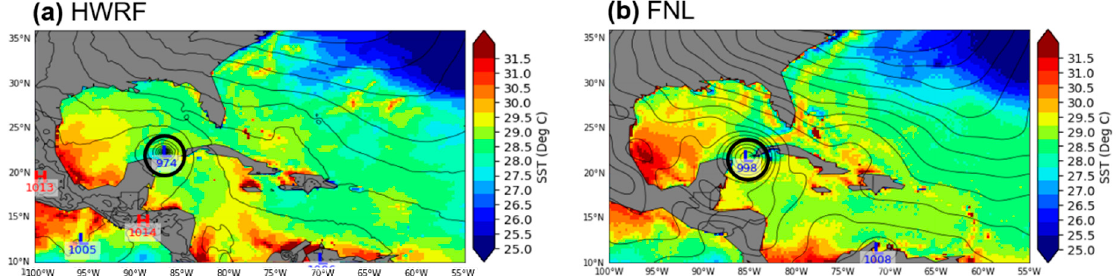
Figure 9. Sea surface temperatures (SSTs, shaded) and mean sea level pressure (MSLP, contours and centers) in the environment near Hurricane Irma from ( a ) 12 h into an HWRF forecast initialized at 1800 UTC on 06 October 2018 and ( b ) FNL valid at 1800 UTC on 08 October 2018. The center position of Michael is identified by a black circle. SST has units of ◦ C, and MSLP has units of hPa.